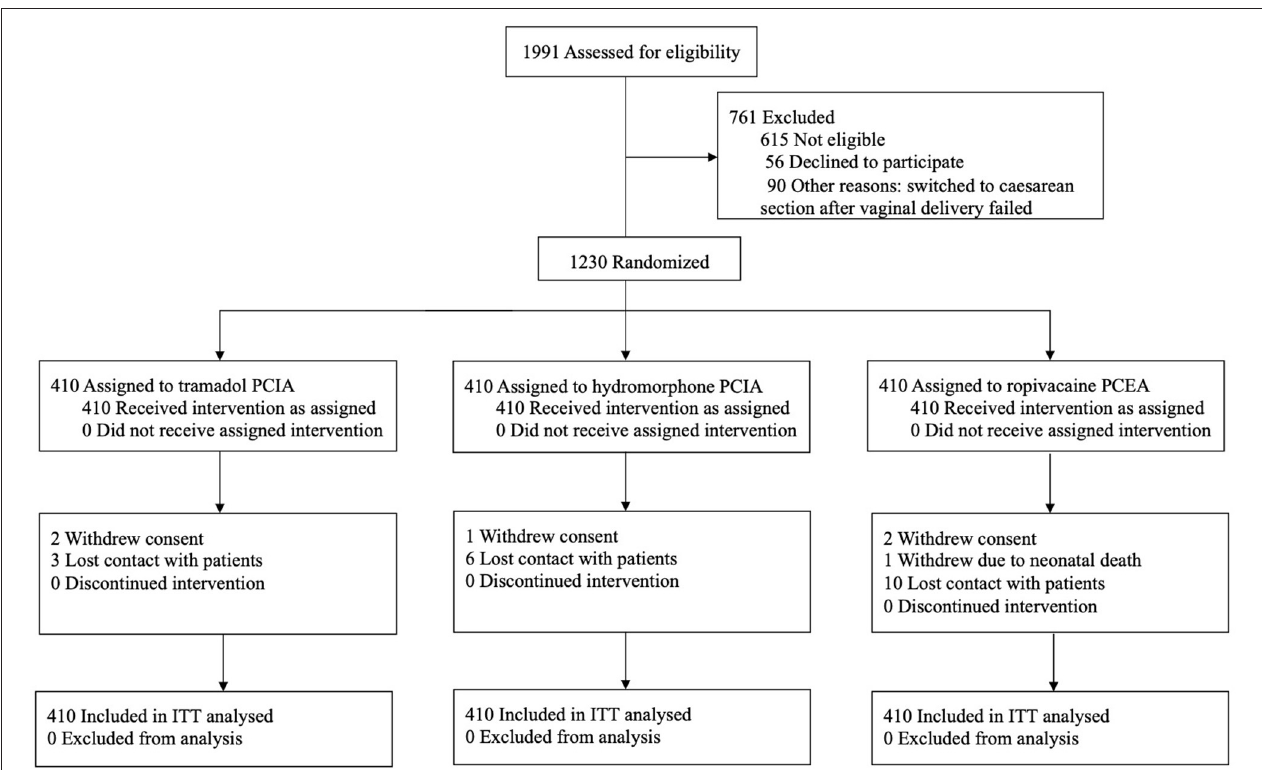
FIGURE 1 | Trial flow ITT analyses included all randomized patients in the groups to which they were randomly assigned. A total of 25 patients (2%) (5 in the TRA group, 7 in the HYD group, and 13 in the ROP group) lacked primary outcome data. ITT, Intention-To-Treat, PCIA, Patient-controlled intravenous analgesia, PCEA, Patient-controlled epidural